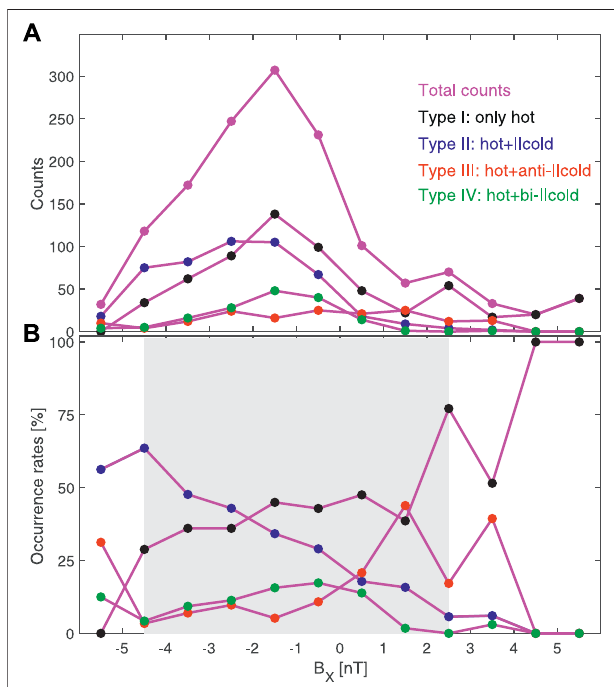
FIGURE 4 | Statistics of the four types of ion VDFs along B X . (A) Counts pro fi les along B X . The magenta curve shows the total counts, and the rest of the curves show the four types of VDFs. (B) Occurrence rates. The gray shadow highlights the interval with total counts over